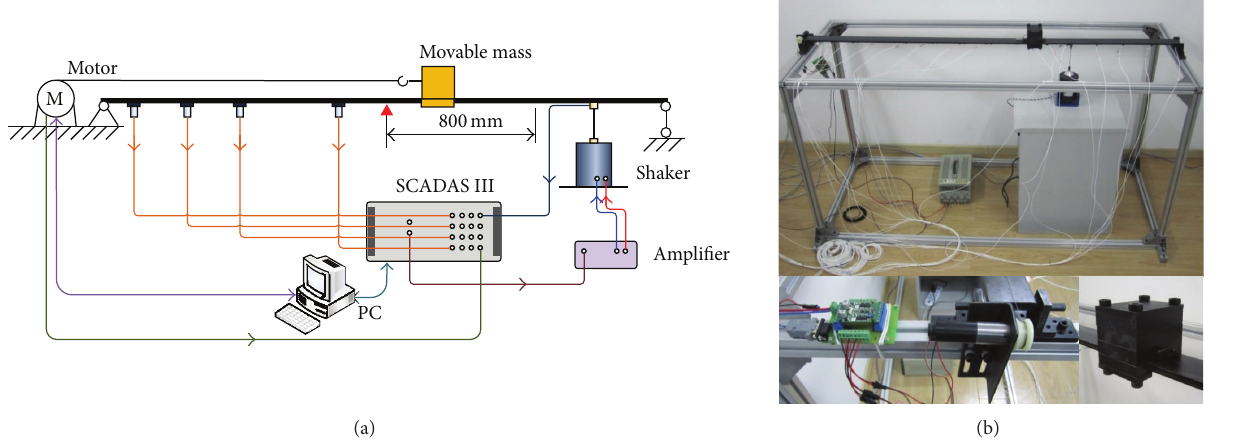
Figure 3: Schematic diagram (a) and real configuration (b) of the experimental structure and its laboratory set-up including the close-up views of the motor and its controller as well as the movable mass.